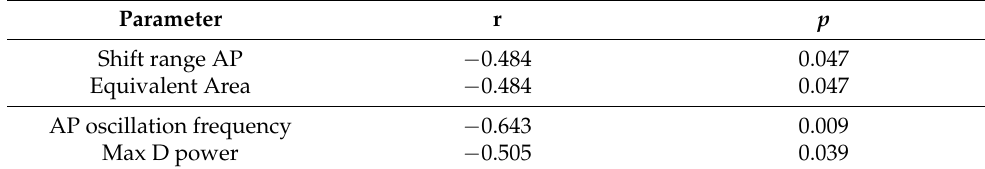
Table 3. Correlation of body height in children with shift and spectral parameters.